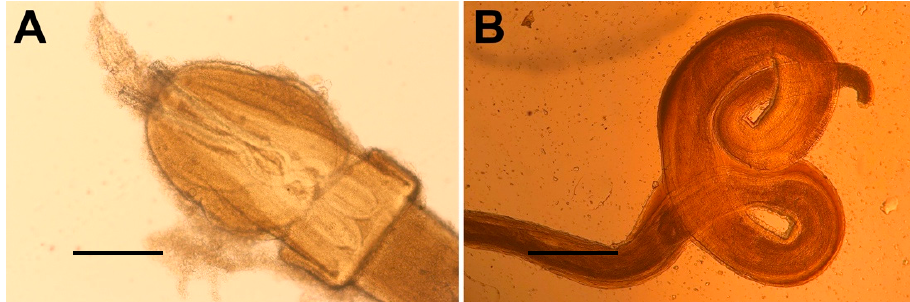
Figure 4. Gastrointestinal parasites found in S. canicula in the present study. ( A ) Nybelinia sp. (Few,